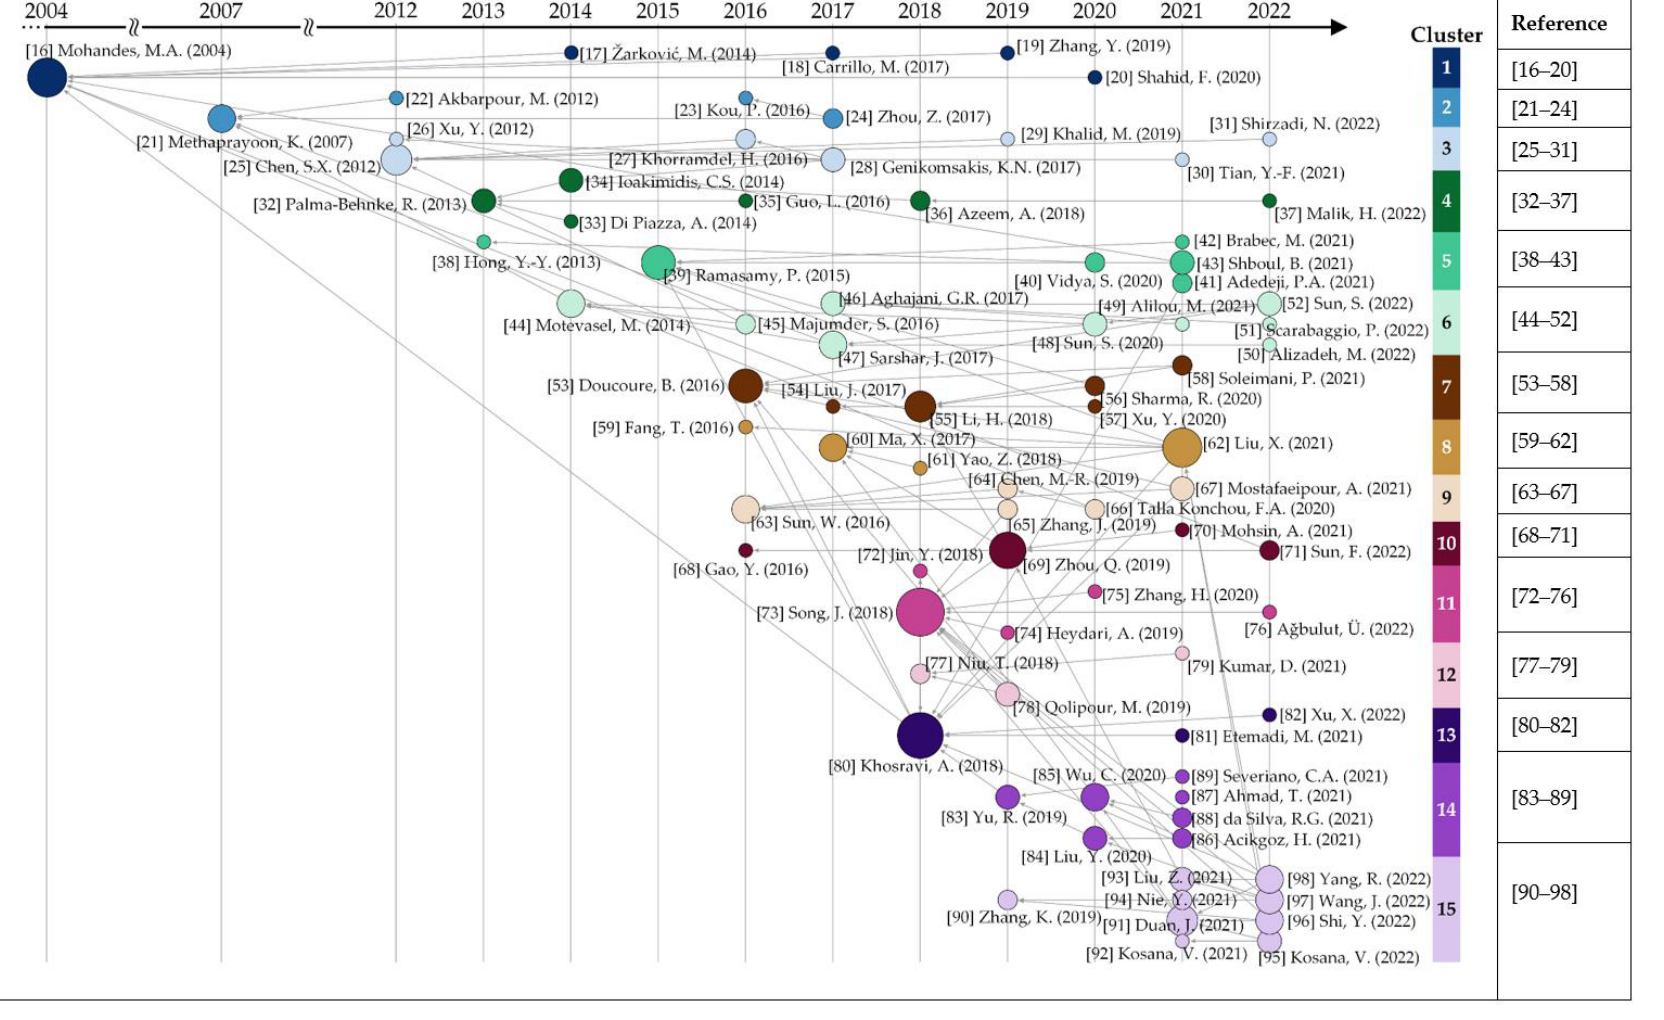
Figure 4. A journal article citation network for the topic “Forecast of wind speed and power applied in power system”, organized chronologically and distributed by cluster with the respective references [16 – 98].